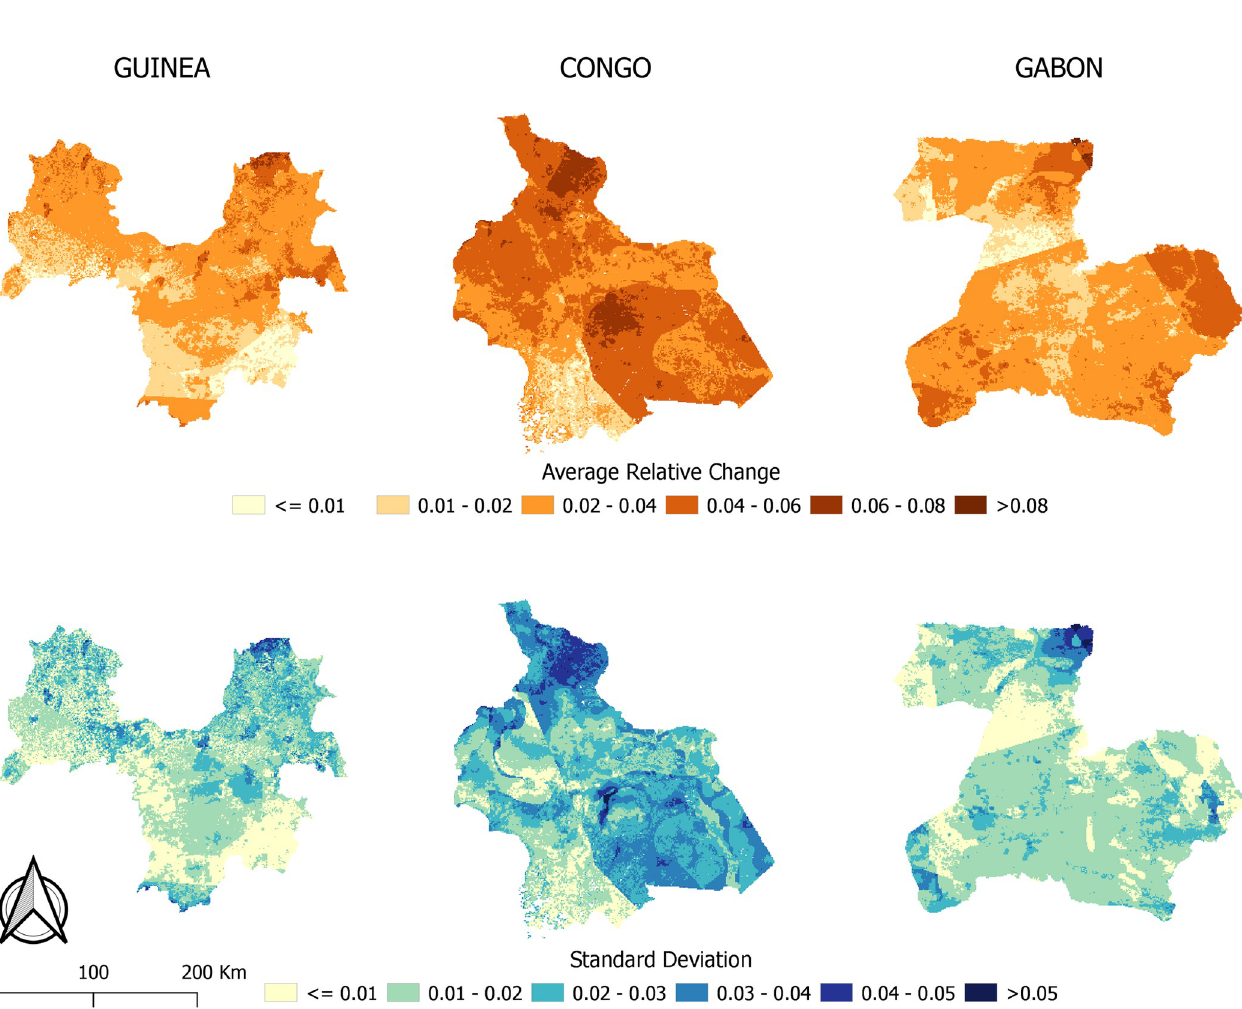
Fig 9. Average relative change and standard deviation of suitability maps for EBOV spillover in the study areas in Guinea, Congo (December 2001) and Gabon (dataset available at https://doi:10.18167/DVN1/FZANMS).